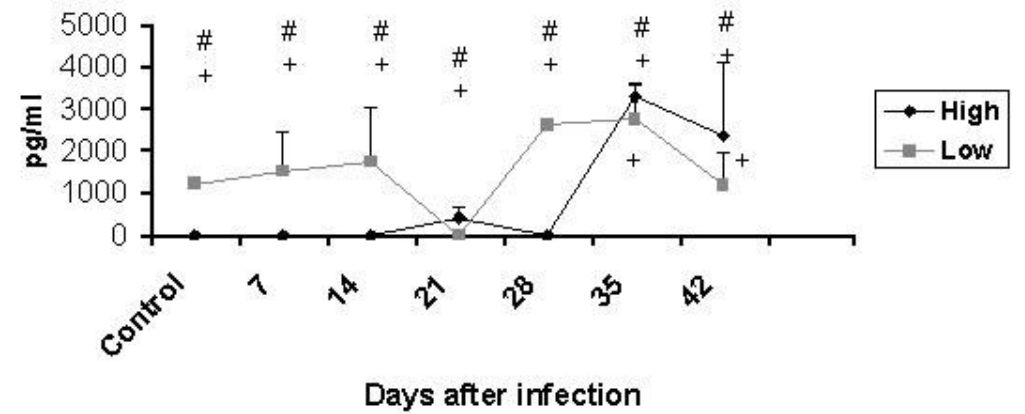
Figure 9. Concentration of TNF- α (pg/ml) in sera from High and Low antibody producer (Selection IV-A) mice infected with Mycobacterium bovis- AN periods, compared with their respective